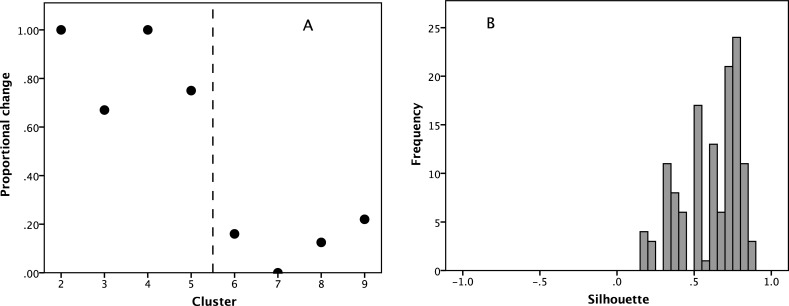
(a) Proportion of clusters whose mean size changes by more than the first decimal place between the k = x and k = x+1 cluster solution. (b) Distribution of silhouette values for a k = 6 solution.